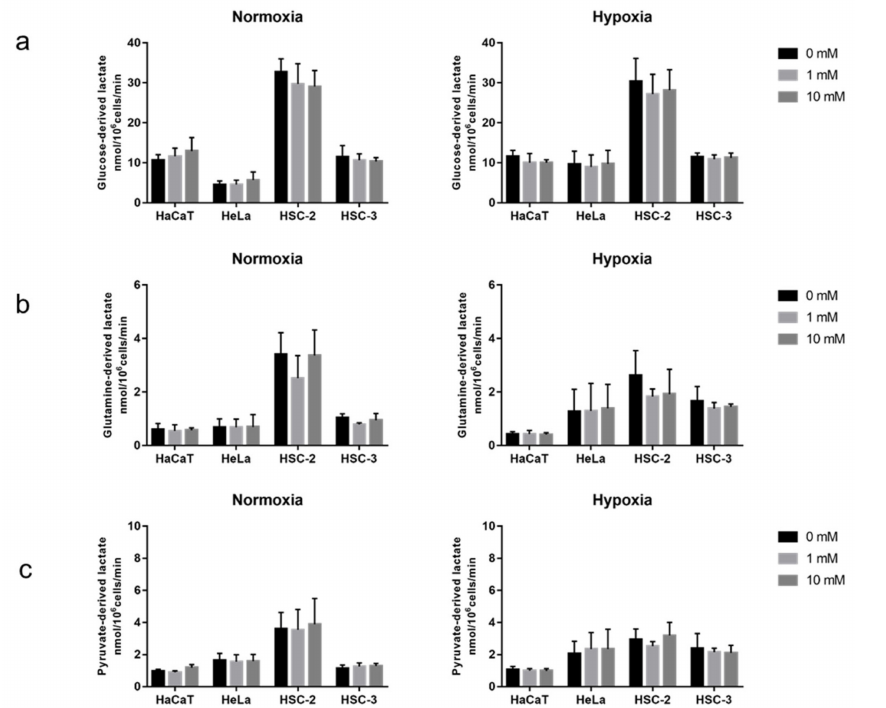
Figure 2. Instant effects of metformin on cellular metabolic activity. ( a ) Glucose-derived lactate in normoxia ( left ) and hypoxia ( right ). ( b ) Glutamine-derived lactate in normoxia ( left ) and hypoxia ( right ). ( c ) Pyruvate-derived lactate in normoxia ( left ) and hypoxia ( right ). A one-way ANOVA and Tukey’s test. All experiments were independently performed in triplicate.